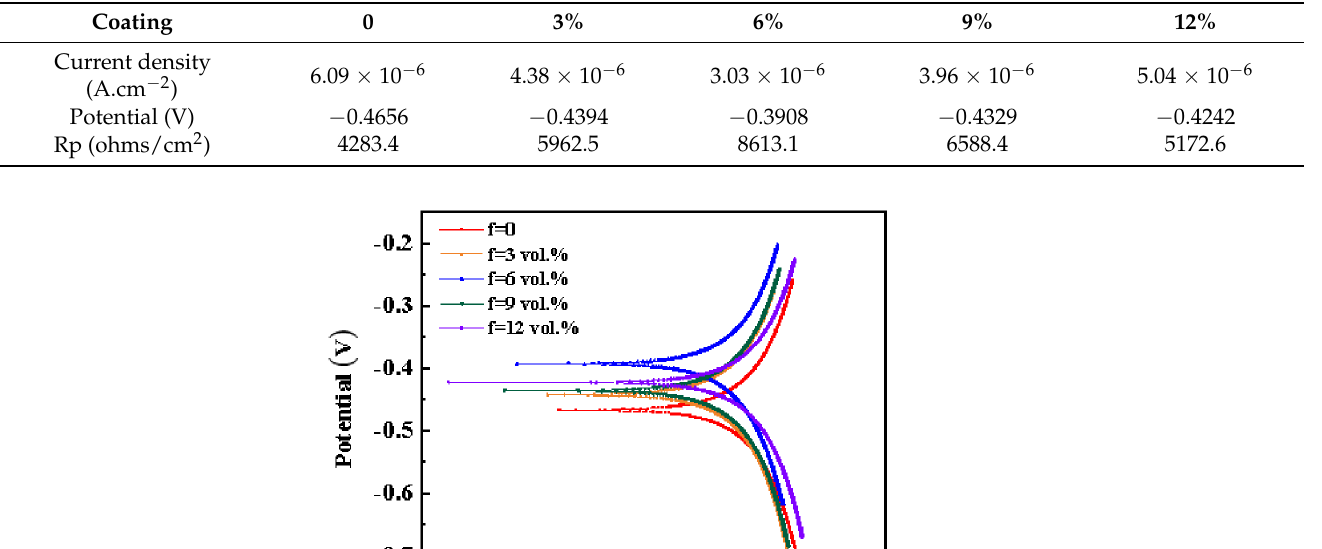
Table 4. Corrosion potential, polarization resistance, and polarization current density of the coatings.